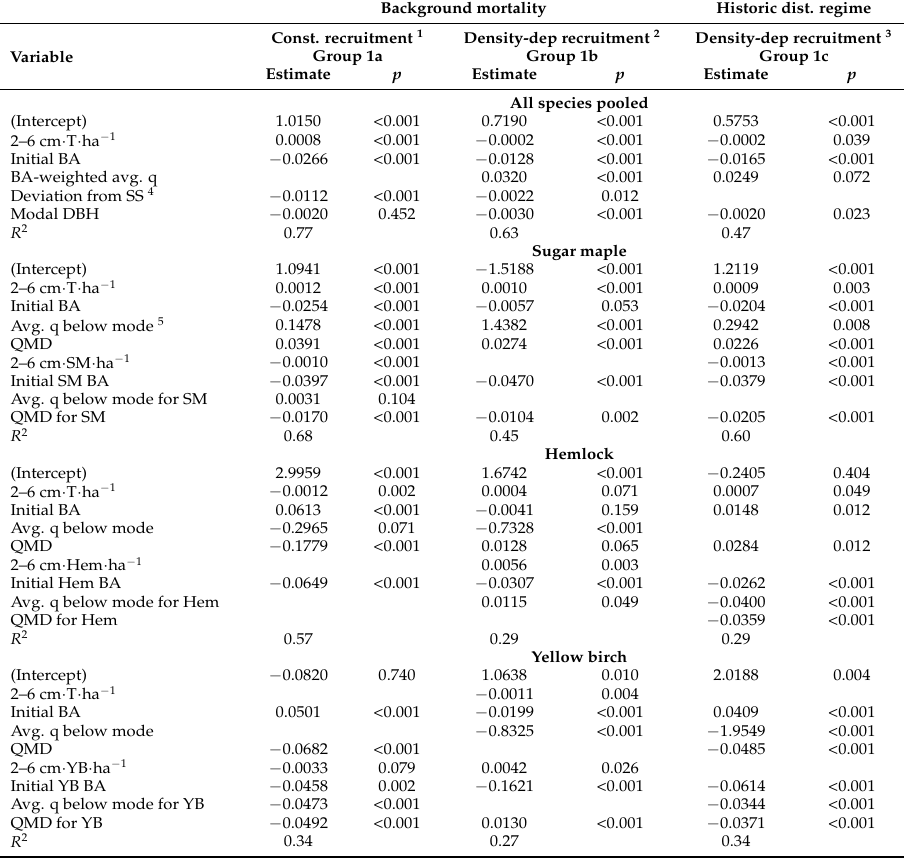
Table 3. Multiple regressions to predict sustainability index based on simulations of the upper Michigan field